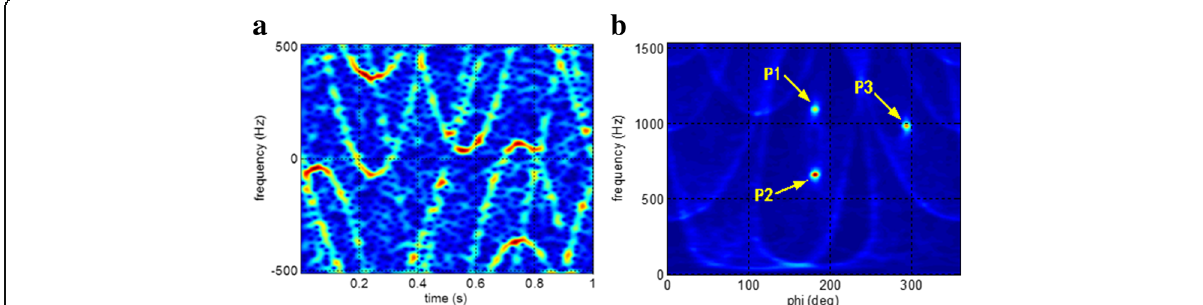
Fig. 7 Results of experiment No. 2. (carrier frequency: 220 GHz, SNR: 3 dB, scattering centers: P1, P2, and P3). a The time-frequency image. b The parameter space image